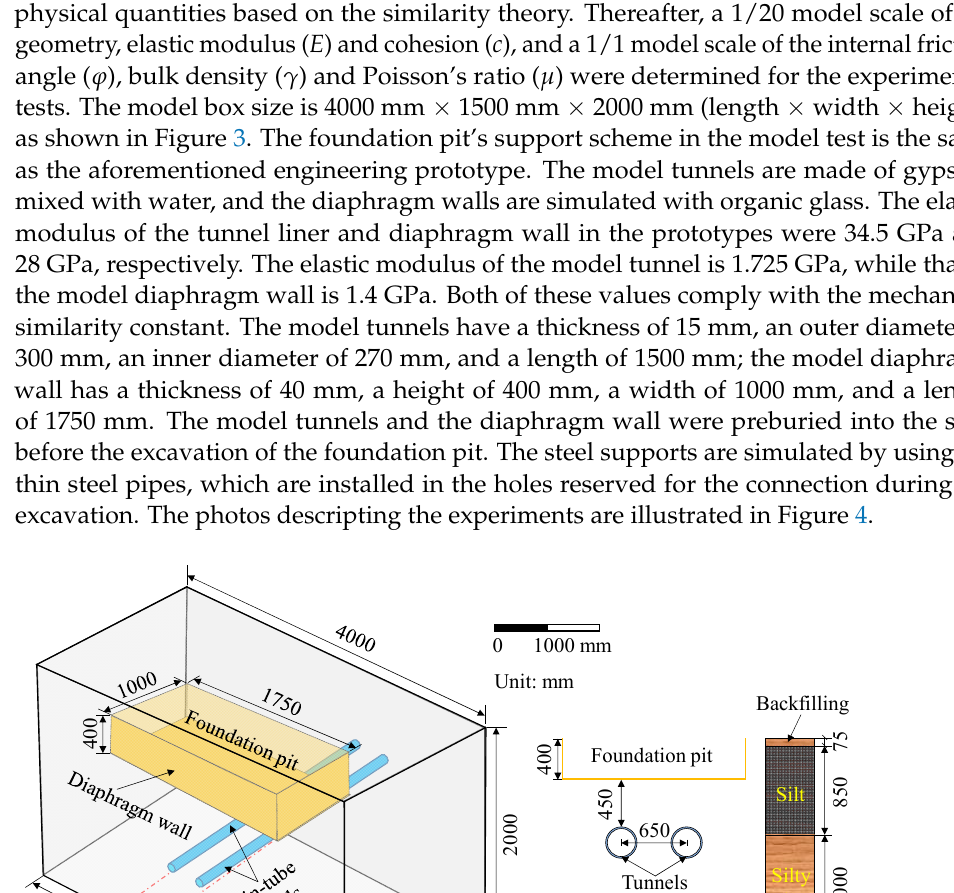
Figure 4. Some photos captured during the experiments, ( a ) mixed similar materials, ( b ) model diaphragm wall, ( c ) model tunnel with strain gauge ready, ( d ) material compaction ( e ), installation of twin-tube model tunnel, and ( f ) installation of model diaphragm wall.